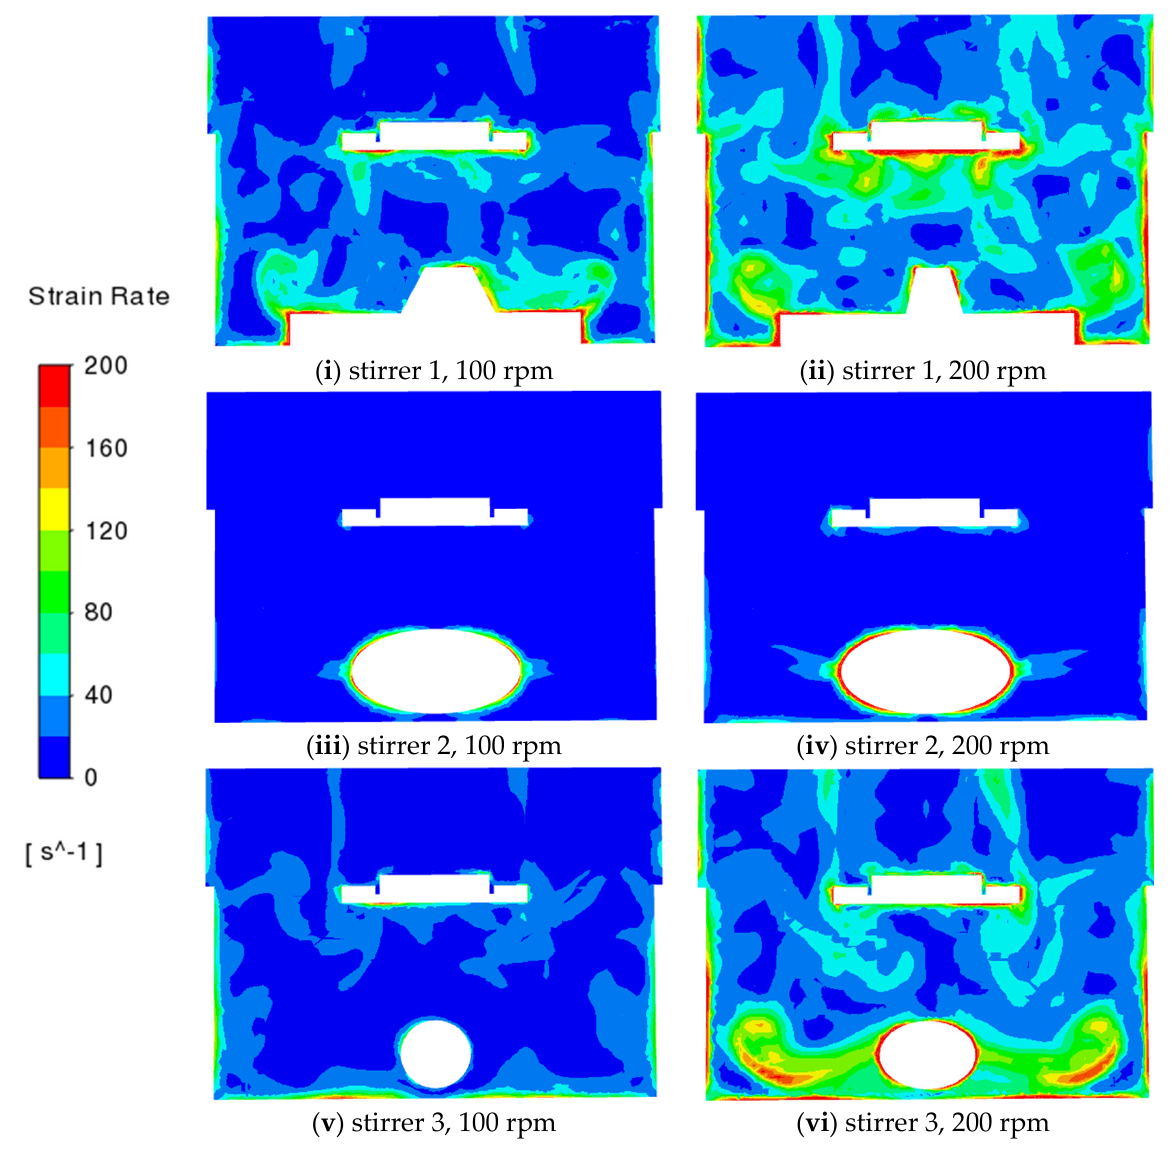
Figure 6. CFD predictions of strain rate on the vertical middle cross ‐ section for different stirrers at different rotation speeds (100 rpm and 200 rpm).